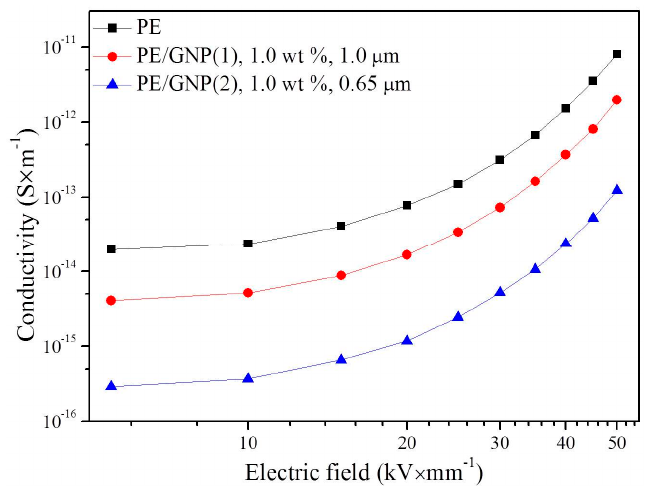
Figure 1. Υ - E characteristic curves of pure PE, PE/GNP(1), 1.0 wt %, 1.0 μ m composite, and PE/GNP(2), 1.0 wt %, 0.65 μ m composite (PE and GNP refer to polyethylene and graphene nanoplatelet,